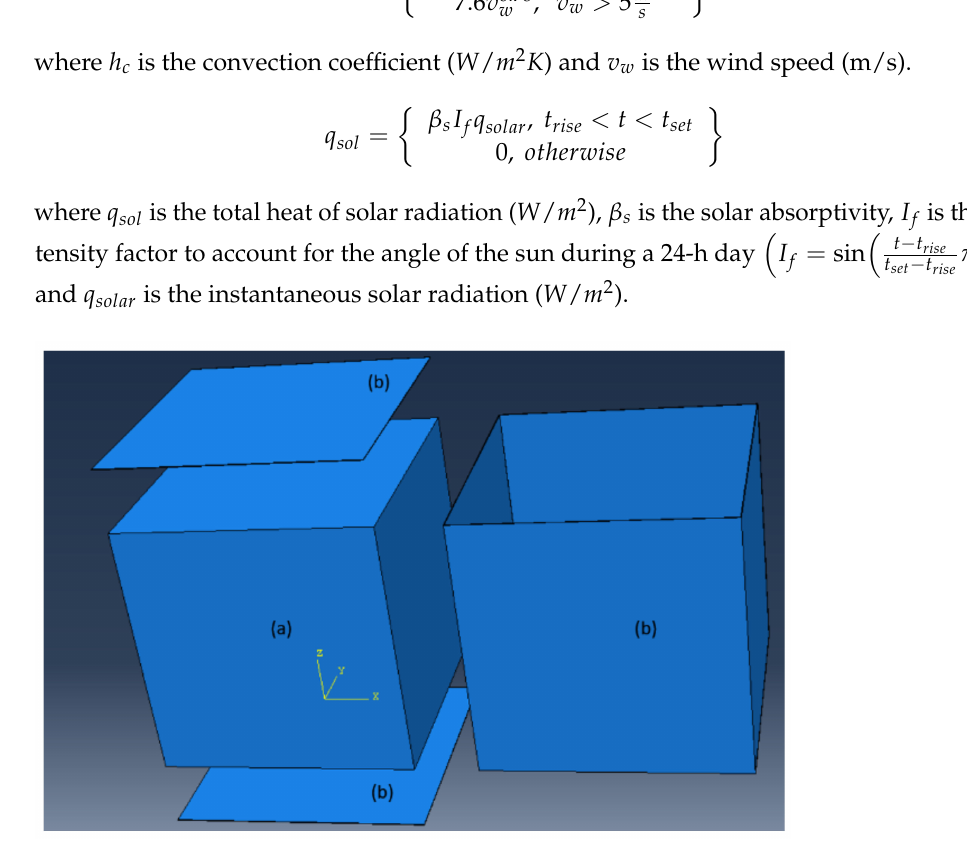
Figure 9. Finite element model: ( a ) Concrete block and ( b ) Steel formwork.